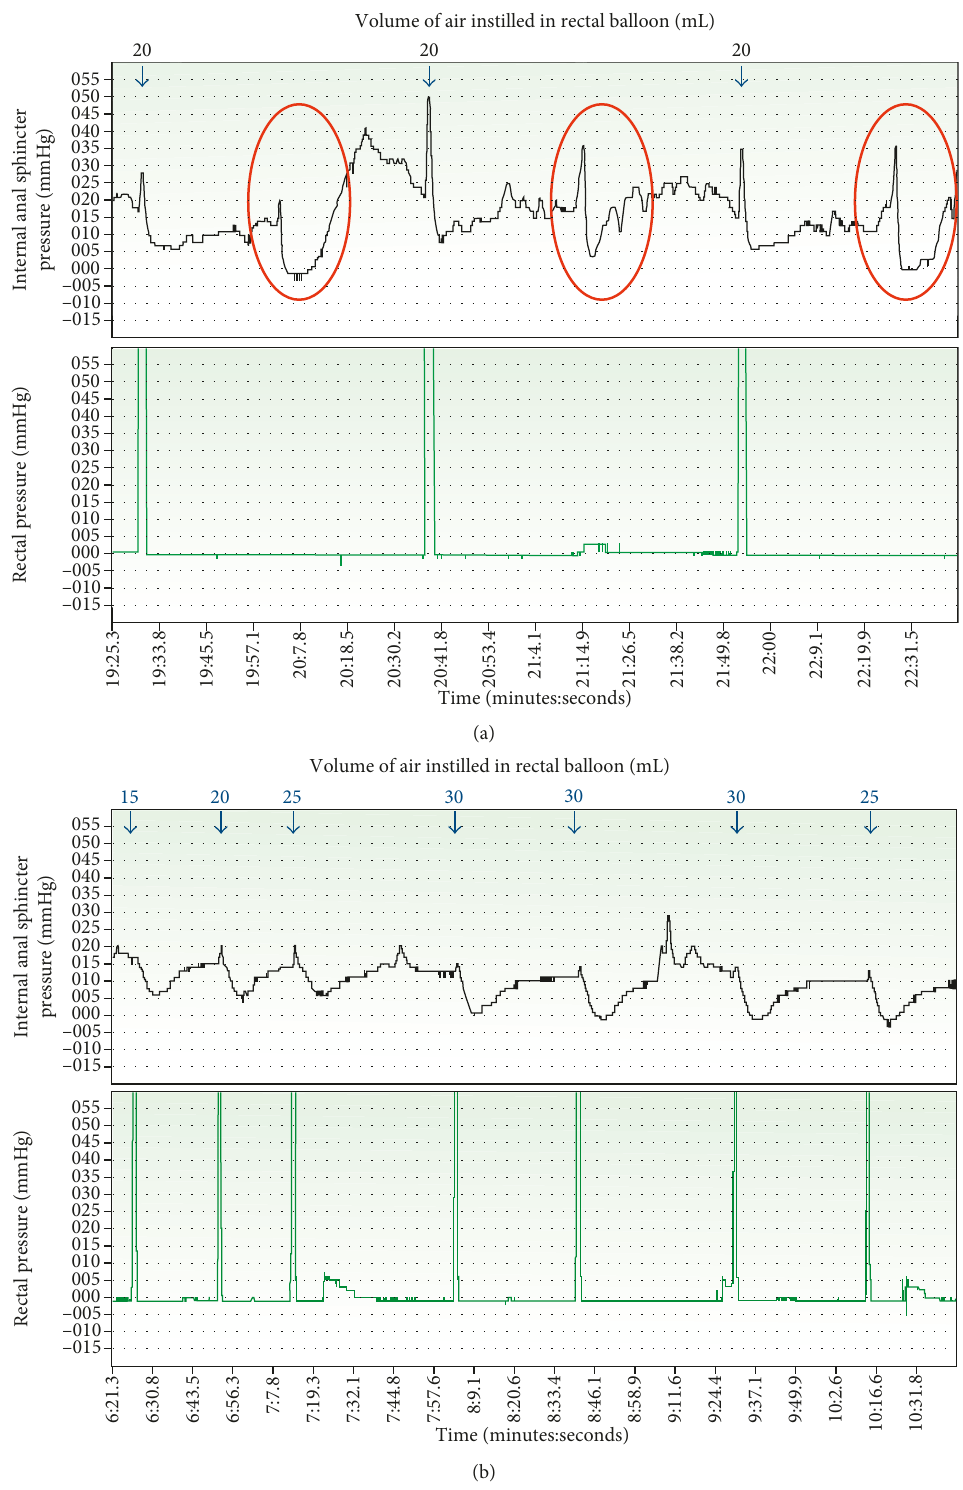
Figure 3: Anorectal manometry (ARM, balloon method) before treatment (a) and six months after adequate treatment with levothyroxine sodium (LT 4 ) (b). ARM was used to measure contractility in the anus and rectum. This technique used a balloon to distend the rectum and a pressure sensor at the internal anal sphincter to measure the presence or absence of the rectosphincteric reflex. (a) ARM showed great variation in the internal anal sphincter resting pressure (in mmHg). Red circles represent transient internal anal sphincter relaxations that occurred independent of the balloon distension pressure (rectal stimulus). This ARM was considered to be inconclusive. (b) ARM six months after replacement therapy with LT 4. The internal anal sphincter resting pressure was normal, without variations. There was no decrease on internal anal sphincter resting pressure without rectal stimulus. Rectoanal inhibitory reflex was present with 15, 20, 25, and 30mL of air insufflated in the rectal balloon. This ARM was considered to be